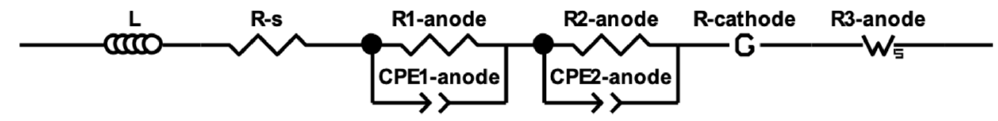
Figure 1. Equivalent Electric Circuit (EEC) used for fitting experimental data.